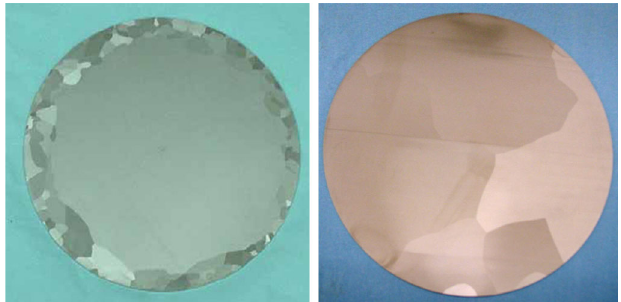
FIG. 7. (Color) Cross sections of two ingots from different manufacturers illustrating large grains, and differences in mor- phology arising from different processing conditions.